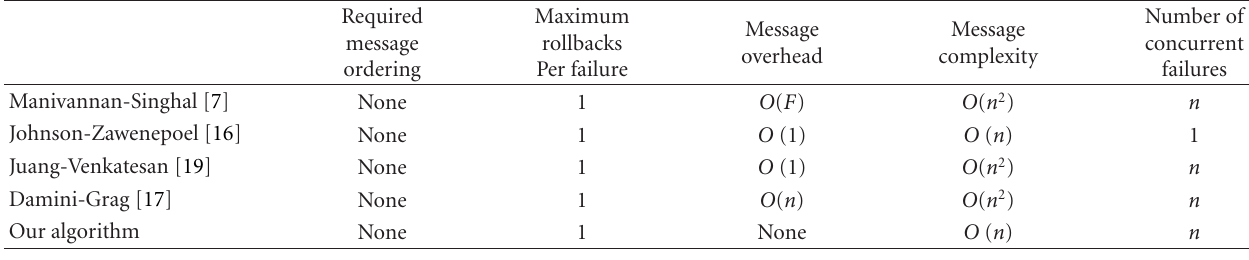
Table 2: Brief summary of